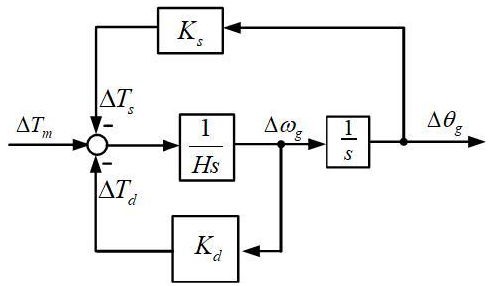
Figure 4. Diagram for demonstrating variations of damping torque Δ T d and synchronizing torque Δ T s .